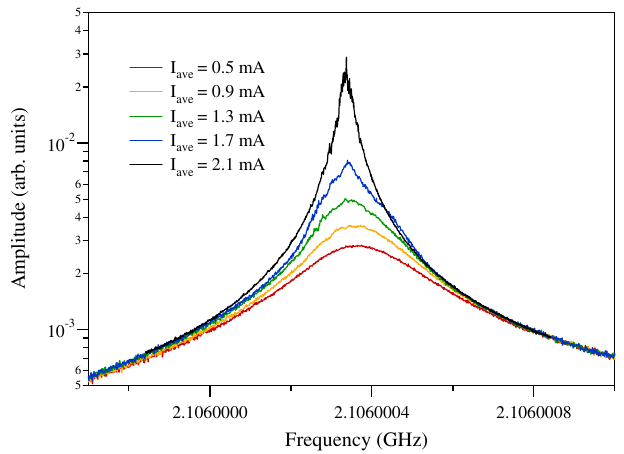
FIG. 4. (Color) The resonance curve for the 2106 MHz HOM as a function of average beam current with nominal, decoupled optics. Note that the effective Q of the curve increases as the current increases. This indicates the system is unstable.